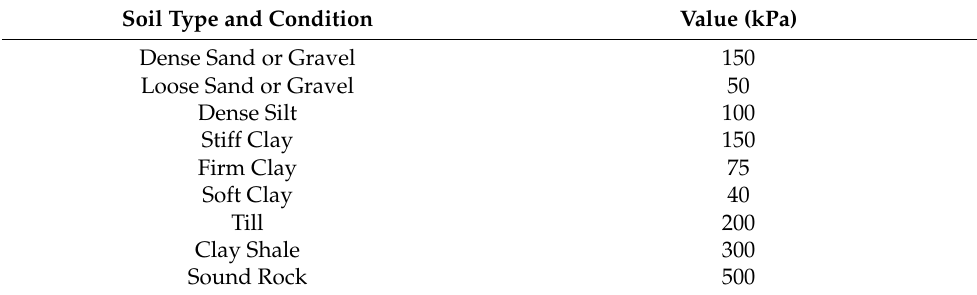
Table A6. Maximum allowable bearing capacity for various soils as per the